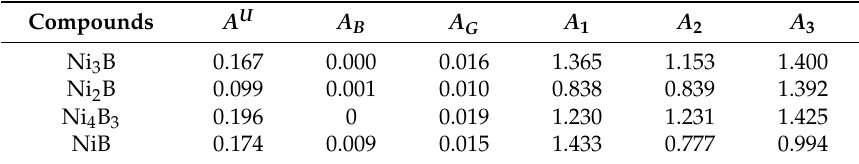
Table 4. The calculated universal anisotropic index ( A U ), bulk anisotropy ( A B and A G ), and shear anisotropic factors ( A 1 , A 2 , A 3 ) of Ni x B y compounds. Compounds A U A B A G A